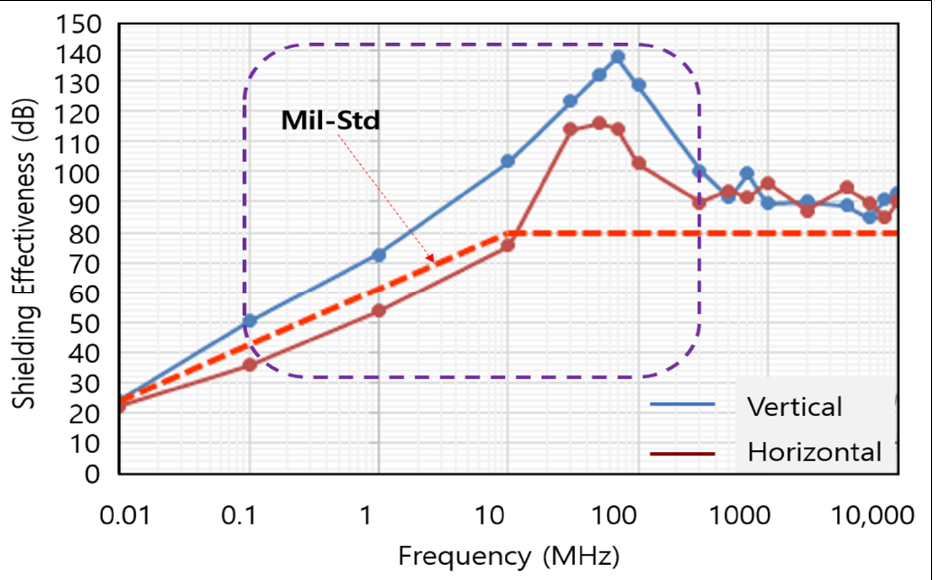
Figure 9. Shielding effectiveness of specimen #6 (W1 = 100, W2 = 20).